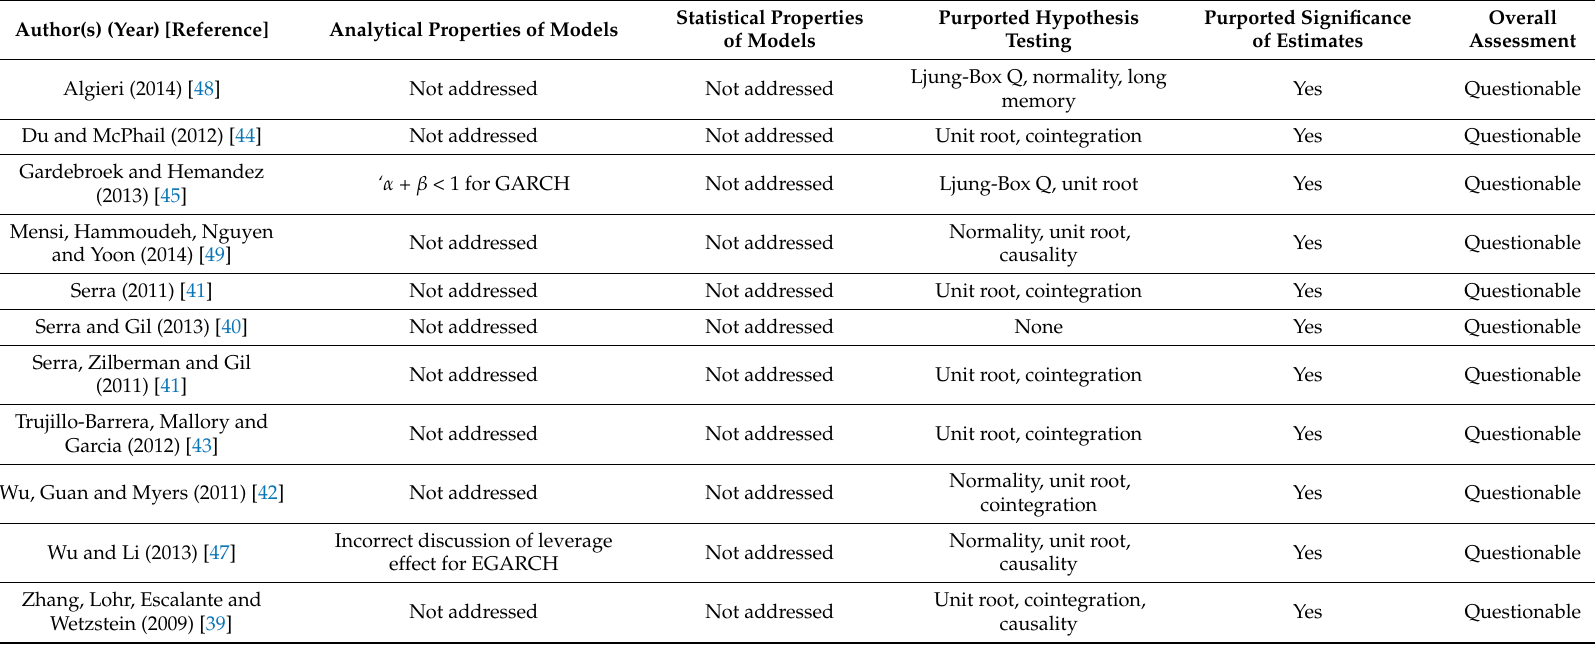
Table 3. Summary of Literature on Volatility between Energy and Agricultural Markets using BEKK and